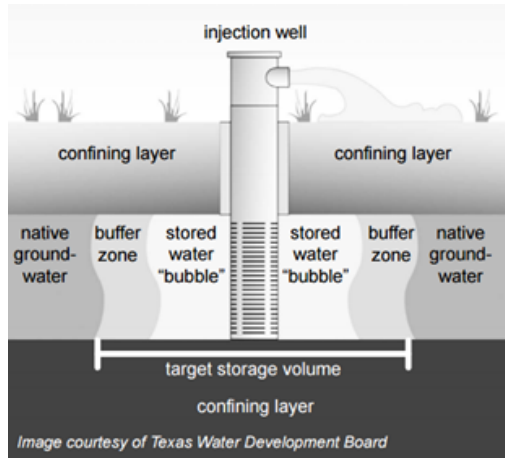
Figure 1. Schematic of an ASR well at the end of recharge and prior to recovery showing the stored water and the buffer zone (after Pyne,